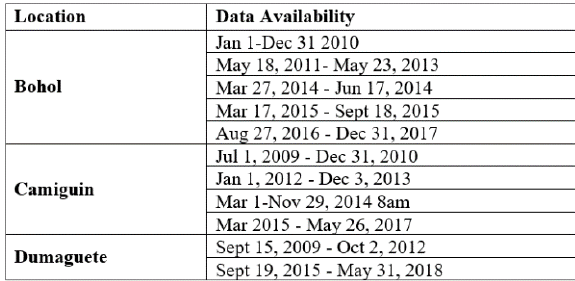
Table 2. Tide gauge data